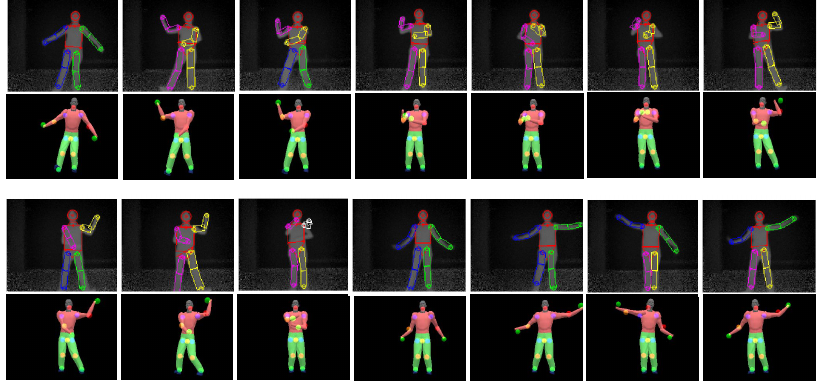
Figure 10. Whole body pose tracking during a dancing sequence. Rows 1 and 3: depth image sequence with the detected body parts. Rows 2 and 4: corresponding reconstructed pose. dancing motion tracking: dance3: